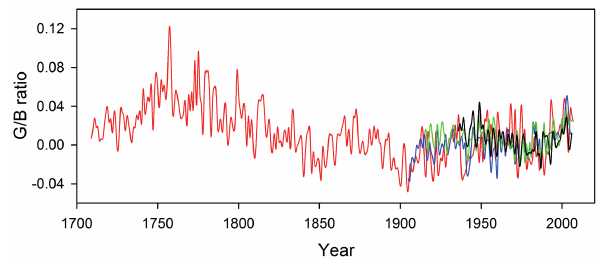
Fig. A1. Annual average G/B anomalies of MASB (red), MAS1 (blue), ANDRA (green) and MAS3 (black). Anomalies were calcu- lated by subtracting the mean annual average G/B value for 1961– 1990 (common period) from individual records. Correlations of records are shown in Table 1.